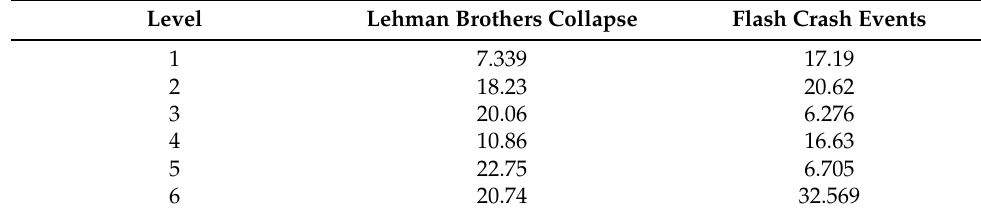
Table 4. Power spectra for WMT stock market data.